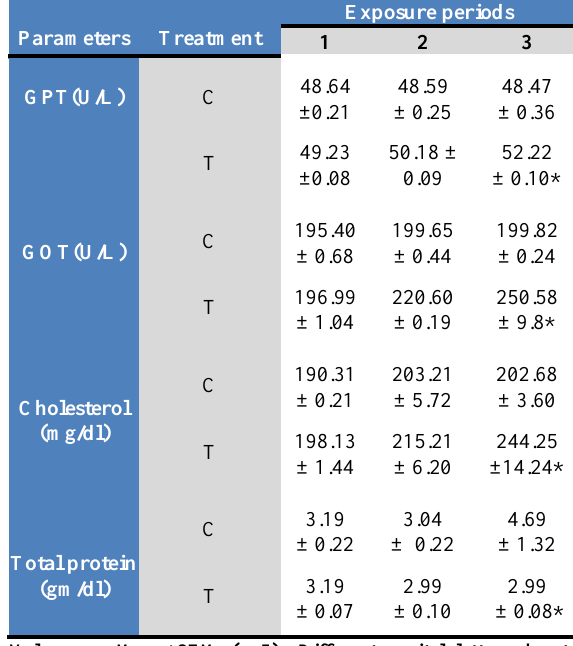
Values are Mean±SEM (n=5) *Different capital letters denote significant results (P<0.05) between different groups. (C) control group: Fish feed throughout the experimental period on the feed is non-contaminated with A. flavus . (T) treated group: Fish feed throughout the experimental period on the feed is contaminated with A.